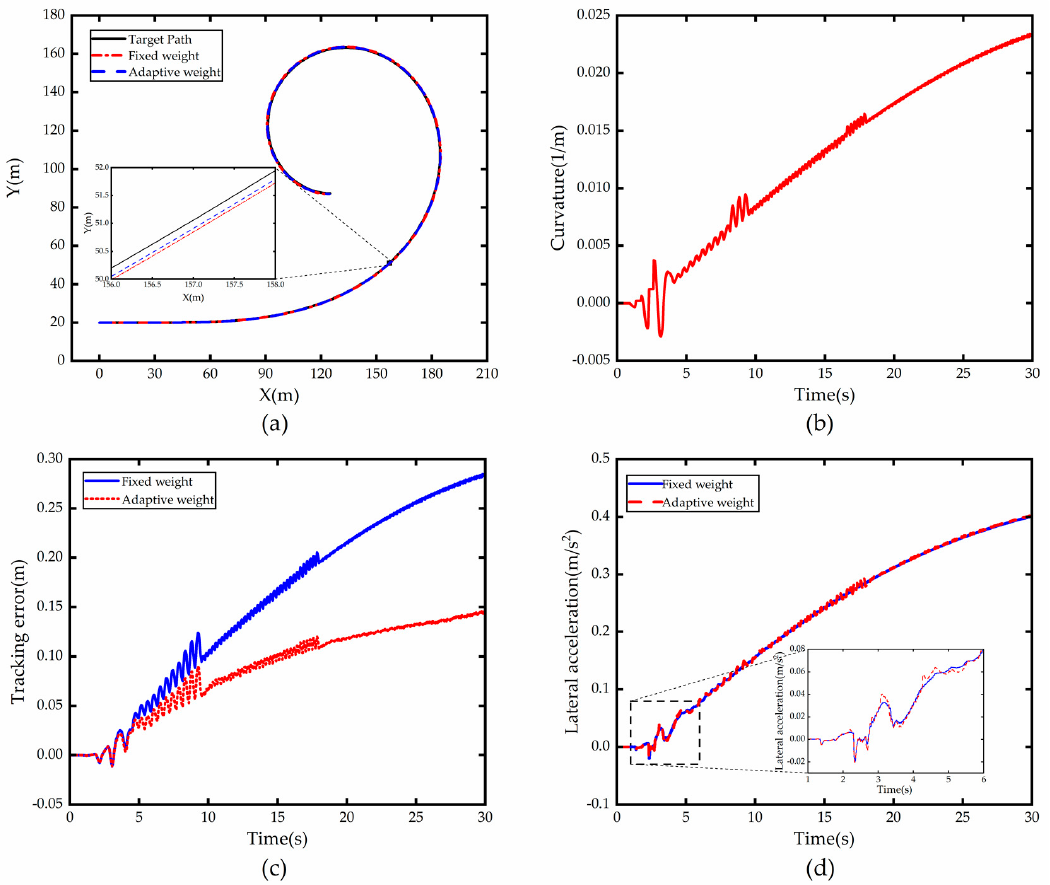
Figure 10. Comparison of 50 km/h simulation results in Scenario 2. ( a ) Path; ( b ) Curvature; ( c ) Track- ing error; ( d ) Lateral acceleration.